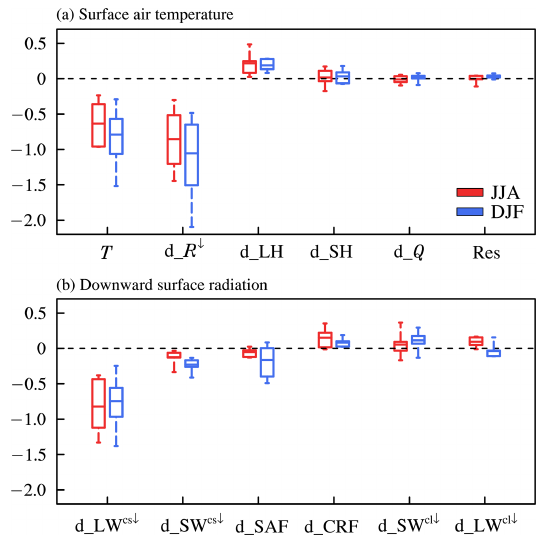
Figure 8. Regionally averaged SAI-induced changes in surface air temperature ( T ) and relevant terms over China during the period of 2030–2069 (units in ◦ C). The terms include surface air temperature changes due to (a) downward net surface radiation change ( d _ R ↓ ), surface latent ( d _LH) and sensible ( d _SH) heat flux changes, heat storage change ( d _ Q ), residual-term change (Res), (b) downward clear-sky surface longwave ( d _LW cs ↓ ) and shortwave ( d _SW cs ↓ ) radiation changes, surface albedo feedback change ( d _SAF), and surface cloud radiative forcing change ( d _CRF; including short- wave ( d _SW cl ↓ ) and longwave ( d _LW cl ↓ ) forcing changes). The error bars represent minimum and maximum values, and the boxes represent interquartile ranges among models. The middle lines present multi-model means. The red and blue box and whisker plots represent values in summer and winter,